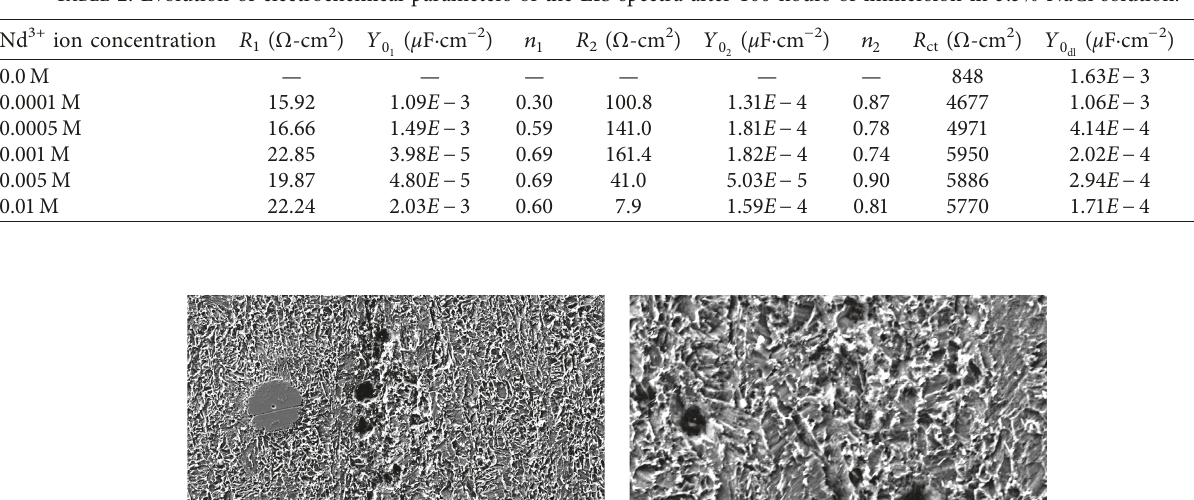
Table 2: Evolution of electrochemical parameters of the EIS spectra after 100 hours of immersion in 3.5% NaCl solution.